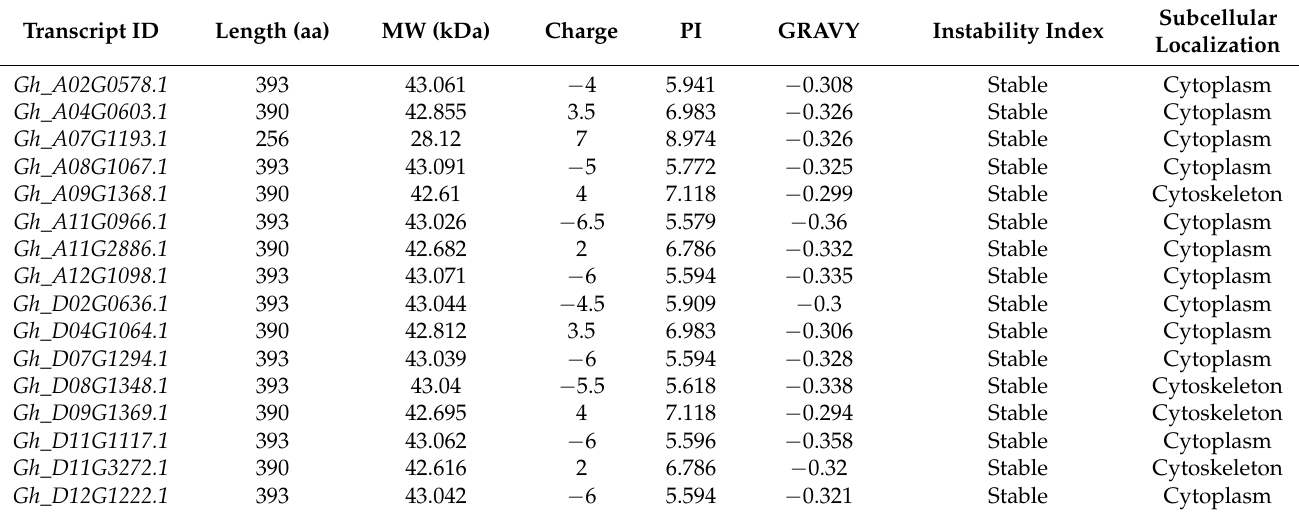
Table 2. The physicochemical properties of cotton SAMS